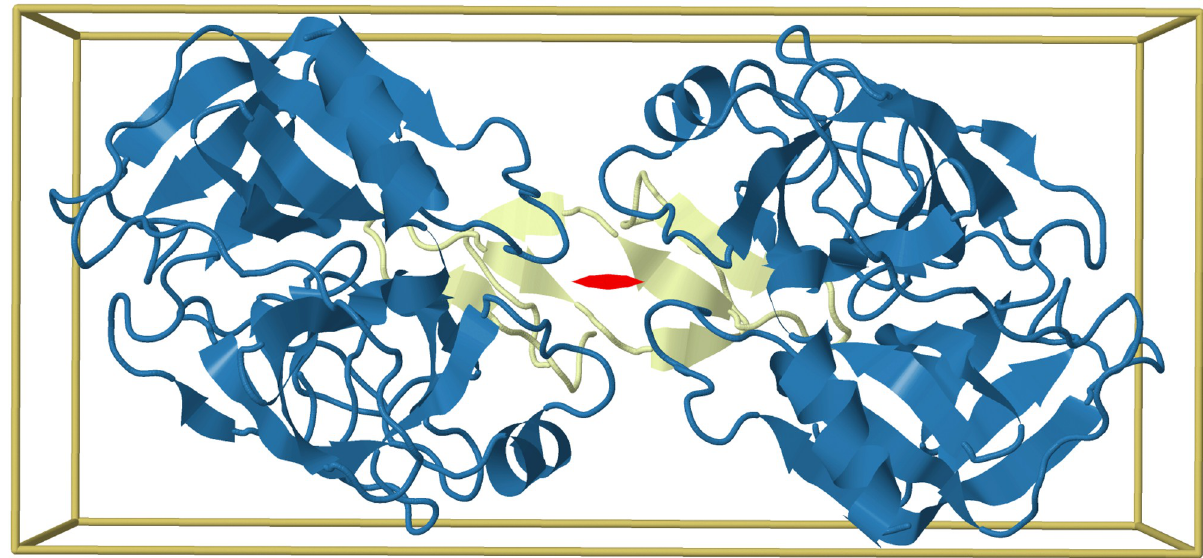
Fig 5. Uneven stoichiometry as a consequence of internal symmetry. The Bowman-Birk inhibitor from snail medic seeds (yellow) forms a complex with two bovine trypsin subunits (blue) in an uneven (A2B) stoichiometry and asymmetric assembly (2ILN). However, a 2-fold symmetry axis (red) can be identified in the complex when the internal symmetry of the inhibitor is taken into account, showing that the complex is equivalent to one with even (A2B2) stoichiometry.